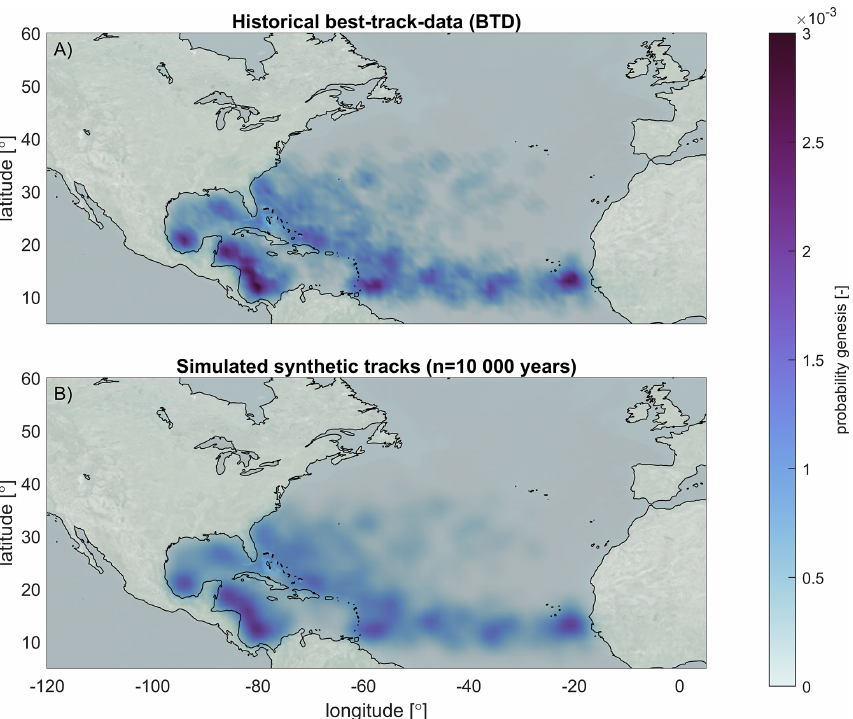
Figure 3. Genesis probability of historical BTD (a) and simulated TCs with TCWiSE (b) for the NA basin. Occurrence is based on TCs within 200km per grid cell for historical TCs from 1886–2019 and 10000 years of simulated events. © Microsoft Bing